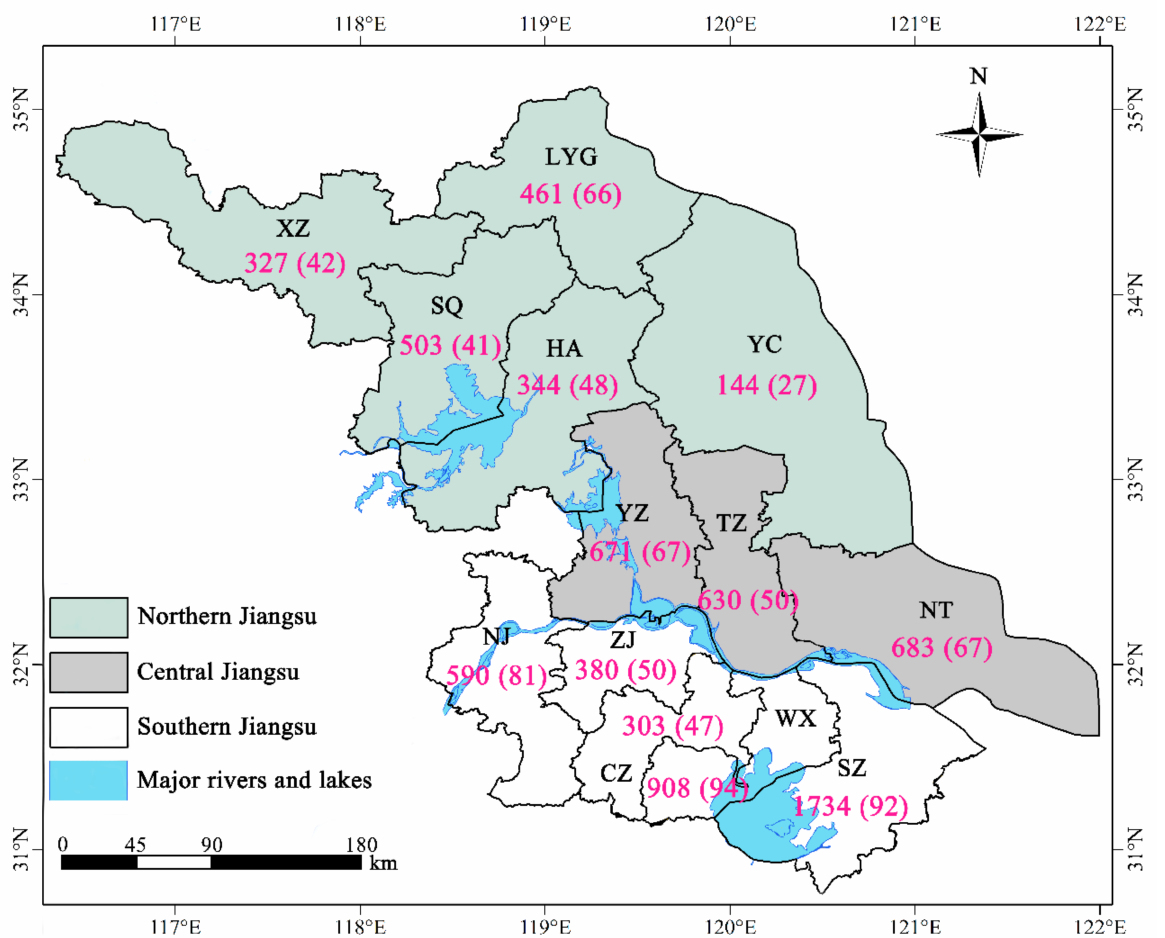
Figure 3. The distribution map showing number and species of heritage trees by 13 cities in Jiangsu Province, eastern China. For each city, the first number on the map indicates individuals, while the second indicates species of heritage trees. Refer to Table 1 for the meaning of the abbreviated